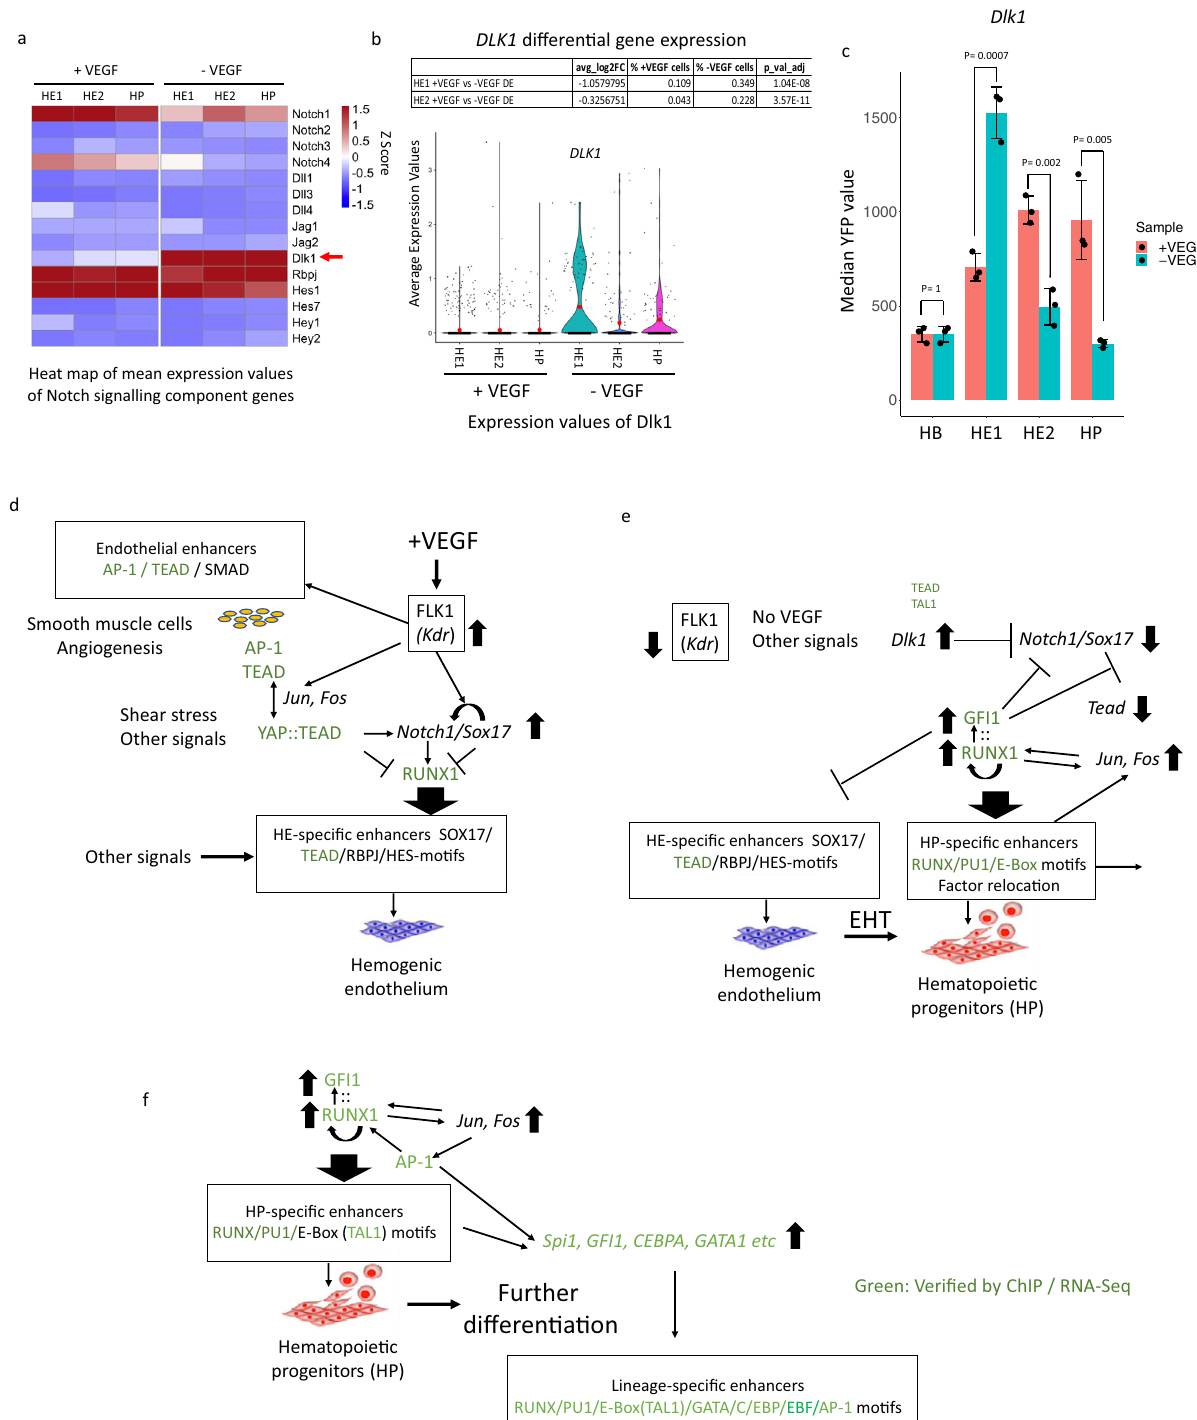
Fig. 8 | VEGF regulates the balance between endothelial and hemogenic development by controlling NOTCH1 activity. a Heatmap showing the expres- sion of NOTCH signaling genes with (+VEGF) and without ( − VEGF) based on single cell expression data. b Differential gene expression analysis of Dlk1 depicted as ViolinplotsasdescribedinFig.7fromcellsculturedwithandwithoutVEGFacross6 clusters for n =2266 cells (black line representing the median and red dot the mean).Differentialgeneexpressiontakenas+/ − 0.25averagelog2foldchangeand